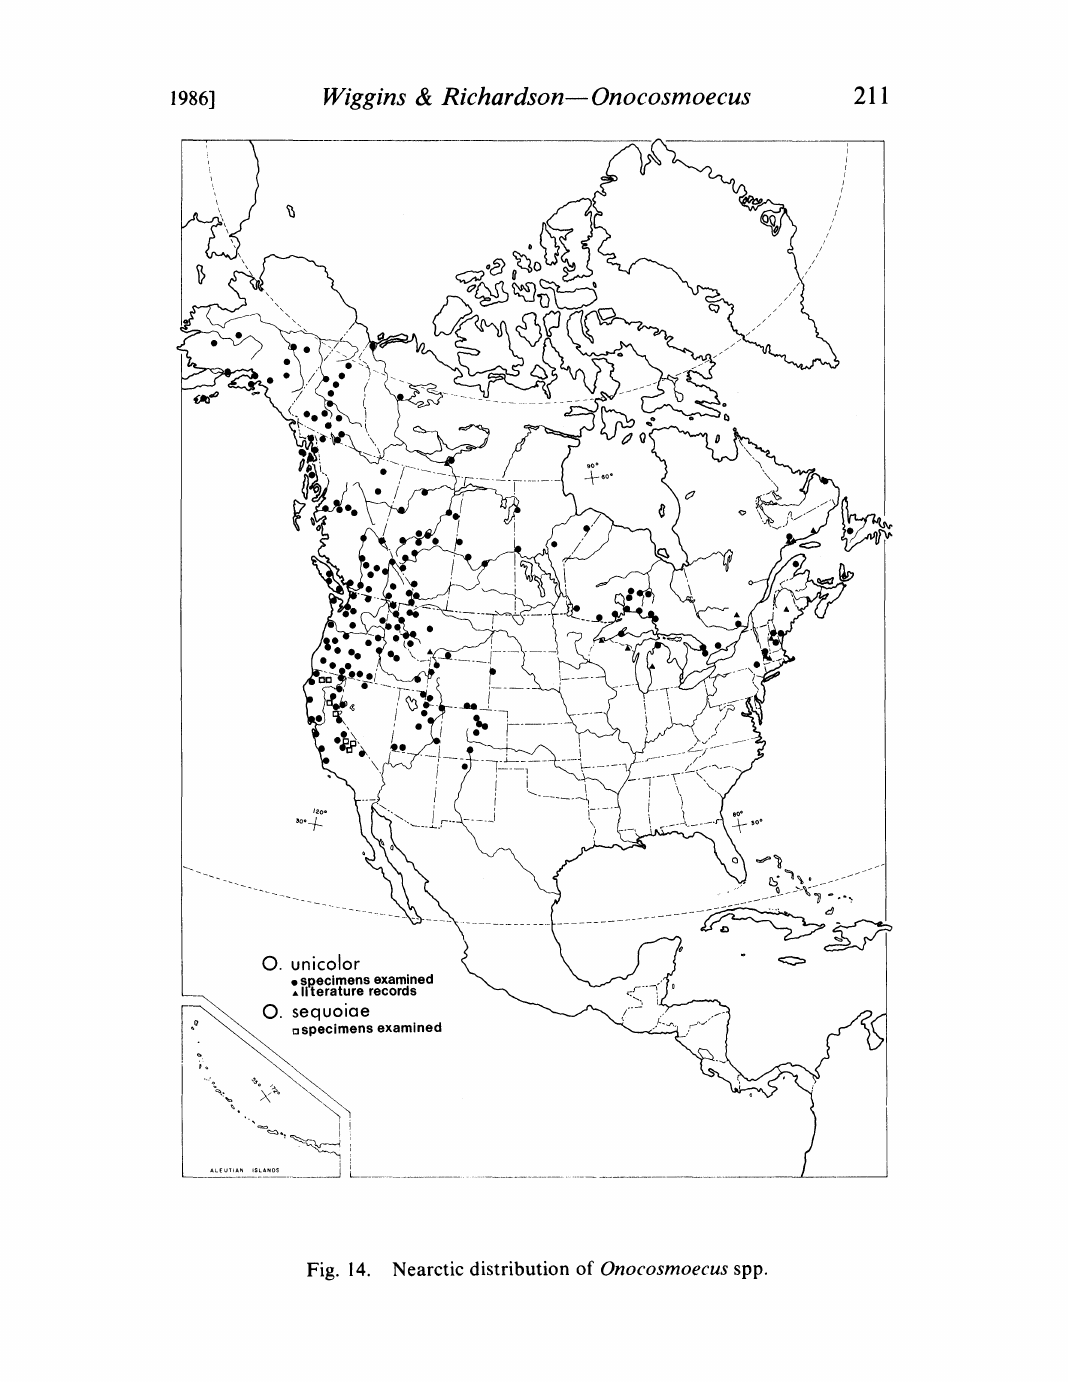
Fig. 14. Nearctic distribution of Onocosmoecus